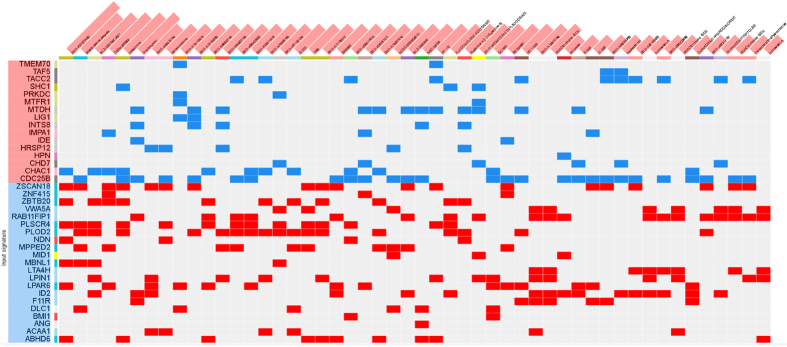
Clustergram with the top ranked L1000 perturbations (e.g. those with most anti-similar signatures).Input genes (rows) are represented by the significantly upregulated (highlighted in red) and downregulated genes (highlighted in blu) obtained from the meta-analysis of GSE73652, GSE44295 and GSE22138. Columns include the top predicted drugs targeting input genes.